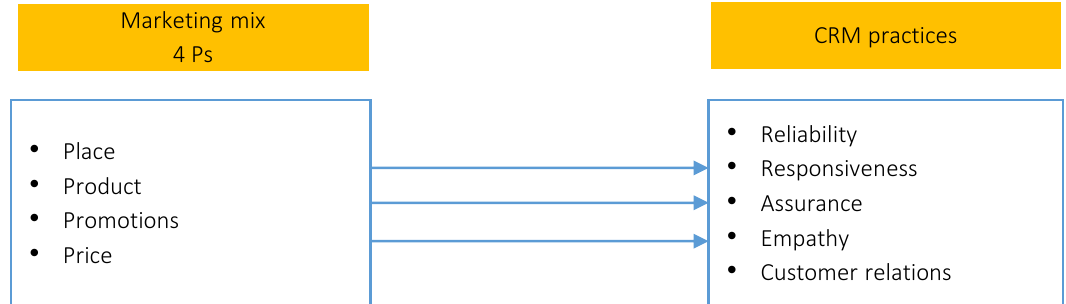
Figure 1. Model of the